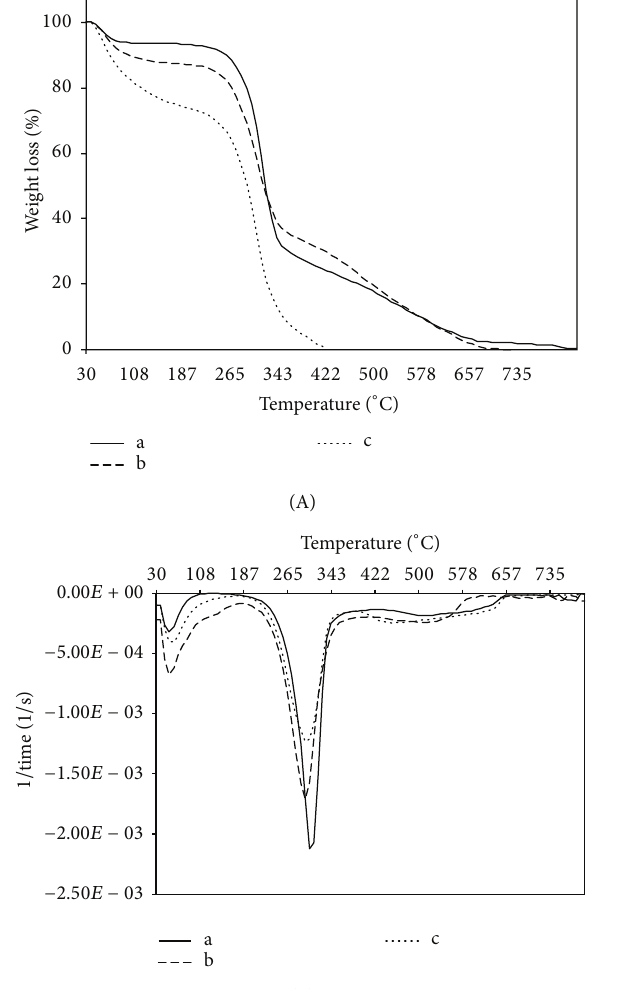
Figure 2: TGA thermograms and DTG curves of (a) OPEFB cellulose, (b) delignified OPEFB, and (c) raw OPEFB.